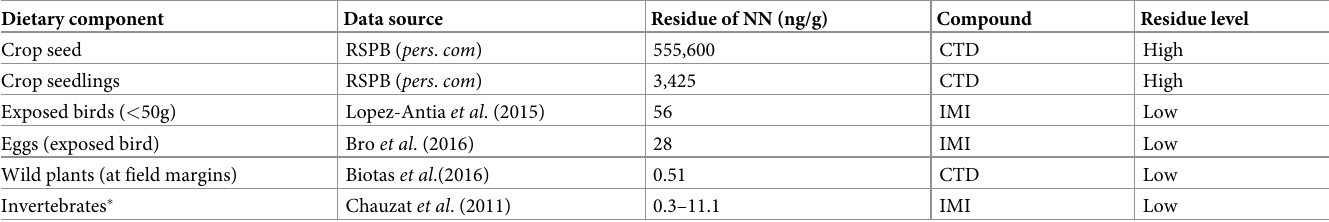
Table 2. Reported concentrations of NN residues in avian dietary